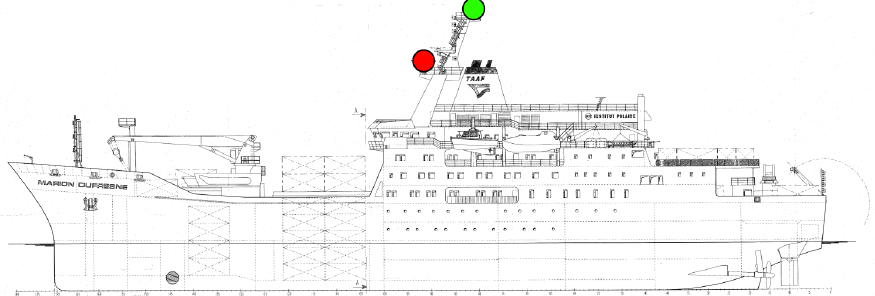
Figure 3. Schematic view of the R/V Marion Dufresne. The coloured circles denote the successive location of the GNSS antenna on ship: in red, the first location (from 1 October 2020 to 10 March 2021); in green the second location (from 10 March 2021). Schematic view is courtesy of Nicolas Marquestaut